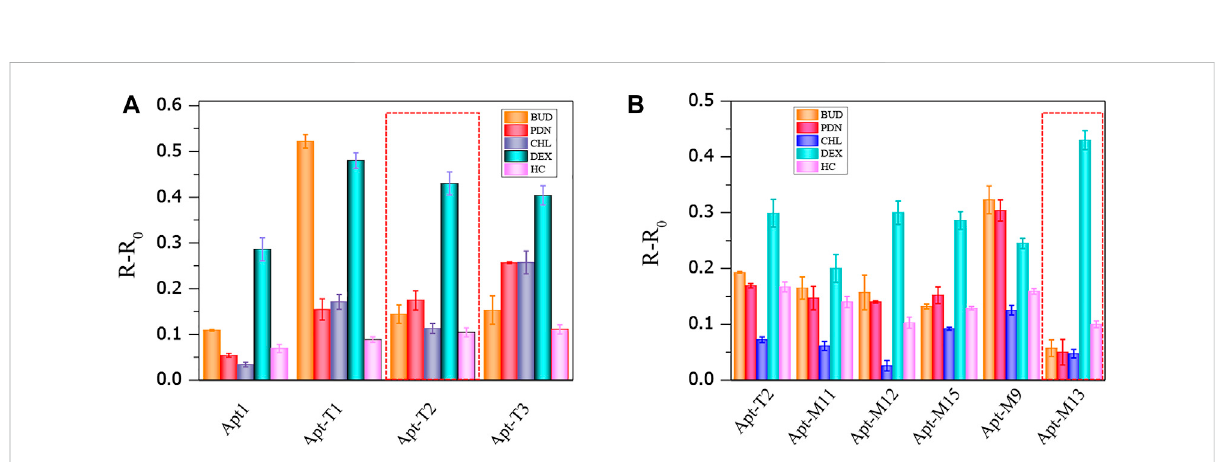
FIGURE 4 Cross-reactivity of truncated aptamer sensors to 100 nmol/ml DEX and analogs (A) , cross-reactivity of mutant aptamers to 50 nmol/ml DEX and analogs (B) .